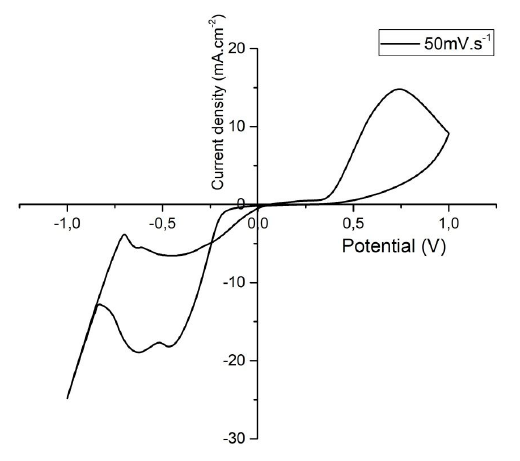
Figure 7. Description of the electrodeposition phases of the CdTe. Source: the